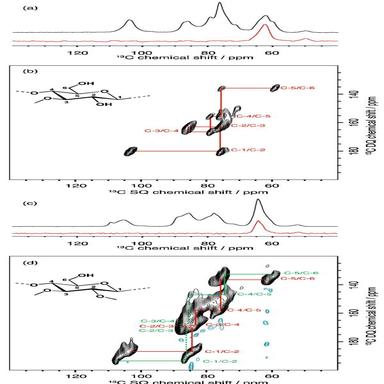
(a) 1 H-13C DNP CPMAS NMR spectrum (black) and 1 H-13C DNP CPMAS NMR spectrum with CH3 selection (red), and (b) 13C-13C DNP CP-refocused-INADEQUATE NMR spectrum of 3-O-methylcellulose impregnated with 10 mM AMUPOL in D2O:H2O 9:1v/v, at 10 kHz MAS and at ca. 100 K. The red path indicates the correlations assigning the 13C NMR spectrum. (c) 1 H-13C DNP CPMAS NMR spectrum (black) and 1 H-13C DNP CPMAS NMR spectrum with CH3 selection (red), and (d) 13C-13C DNP CP-refocused-INADEQUATE NMR spectrum of 2,3-O-dimet